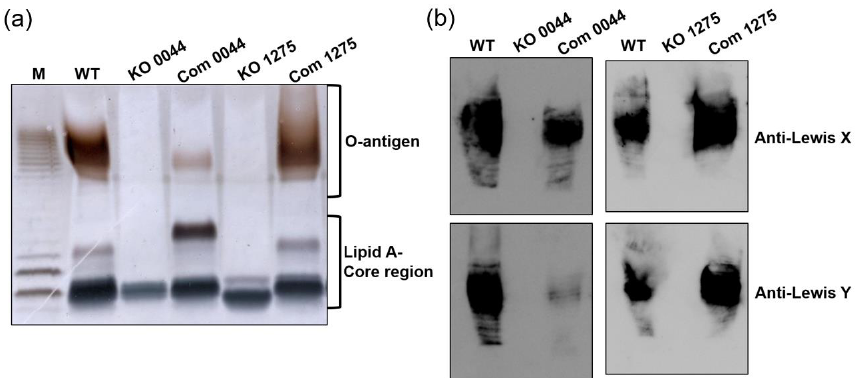
Figure 3. Effects of the HP0044- and HP1275 -disrupted mutations on LPS profile and Lewis antigen presentation. The LPS profiles from wild-type strain 26695, the HP0044 and HP1275 knockout mutants and their corresponding knockout complementary mutants were analyzed by ( a ) 15% tricine-PAGE with silver staining or ( b ) immunoblotting using anti-Lewis X and anti-Lewis Y antibodies. The relative positions of the O-antigen and lipid A–core region were indicated by braces. M, E. coli O111:B4 LPS marker; WT, wild-type strain; KO, knockout mutant; and Com, knockout complementary mutant.